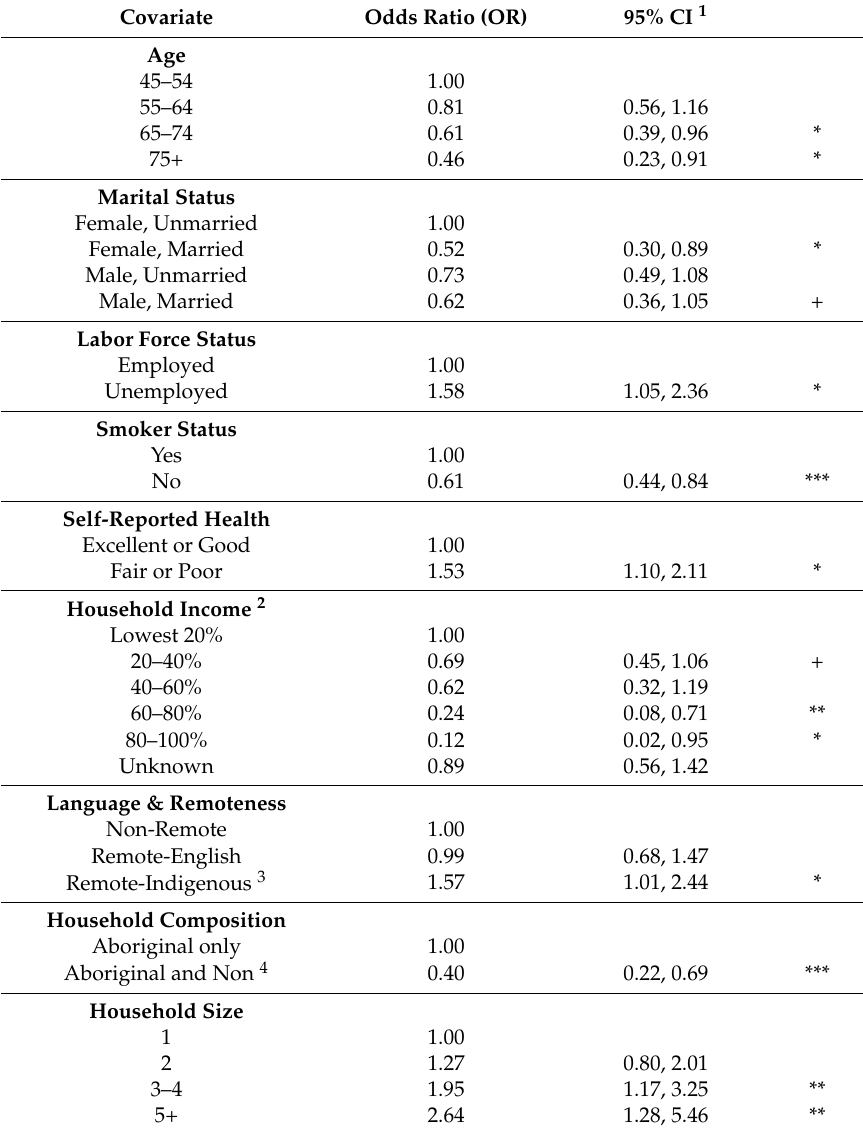
Table 2. Ordered Logistic Regression Model of Food Insecurity,